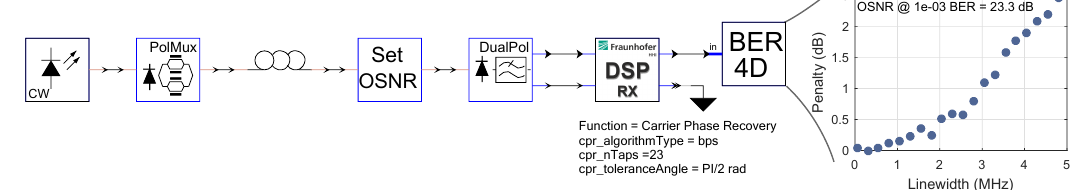
Figure 3. Simulation setup for a lorentzian